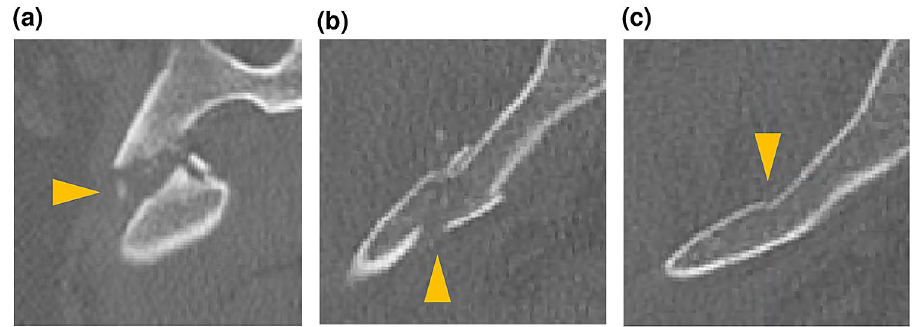
Figure 6. Types of fractures. ( a ) Completely displaced fracture ( F1 ). ( b ) Incompletely displaced fracture ( F2 ). ( c ) Compression fracture ( F3 ). Fractures are indicated by